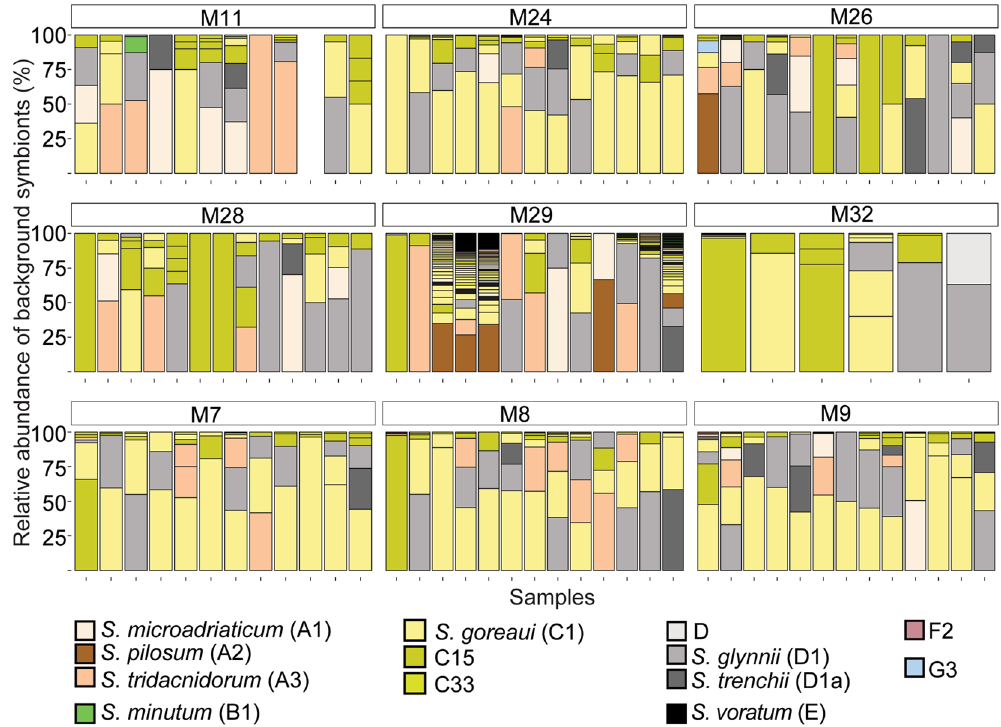
Figure 4. Barplot of variance-normalized abundances of only the background Symbiodinium diversity associated with dams and eggs of Montipora digitata . Colours represent different Symbiodinium types. The dominant type, C15, was excluded for clarity. The first bar in each group is the spawning dam and the following bars represent her eggs. The tenth egg sample from dam 11 (M11) was made up of 100% C15, and was therefore not shown.